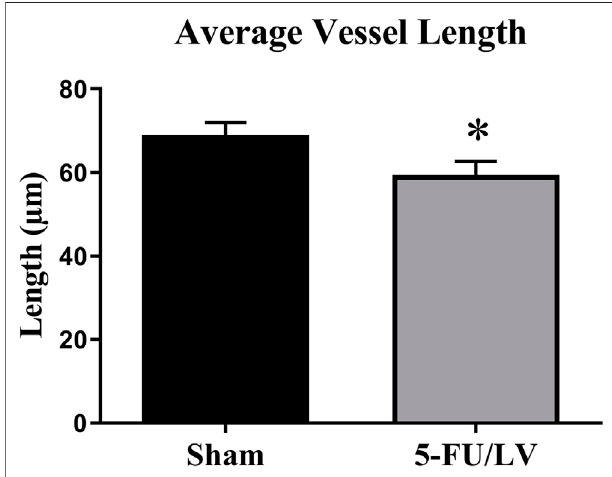
FIGURE 5 | Average blood vessel length in the dorsal DG. 5Fu/LV treatedmicehadasigni fi cantdecreaseinbloodvessellengthinthedorsalDG. Average ± SEM ( n (cid:1) 5 per group) * p <